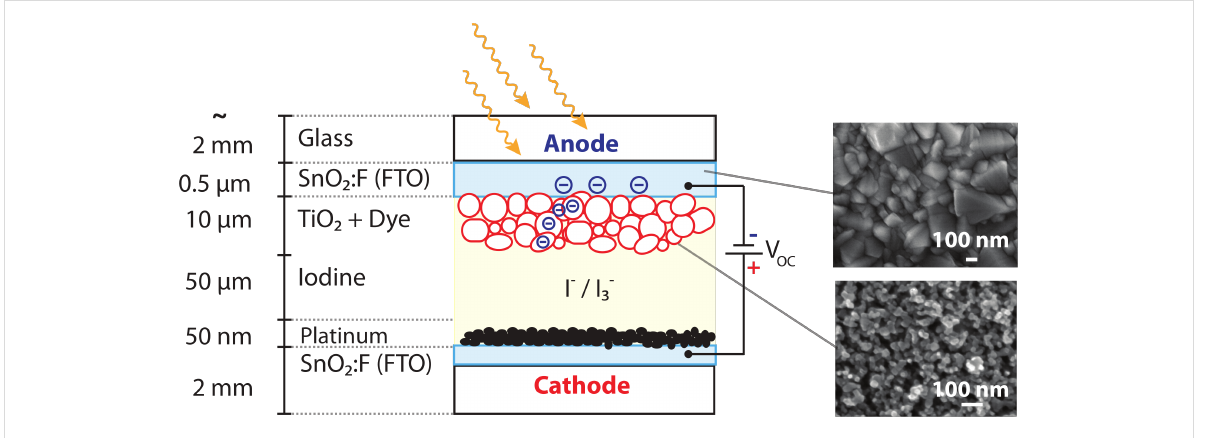
Figure 1: Different components of a DSC under illumination in an open circuit. Upon light excitation electrons are injected from the adsorbed dye molecules into the conduction band, E cb , of the wide-bandgap metal oxide (nanoporous TiO 2 ) resulting in an open-circuit voltage, V oc